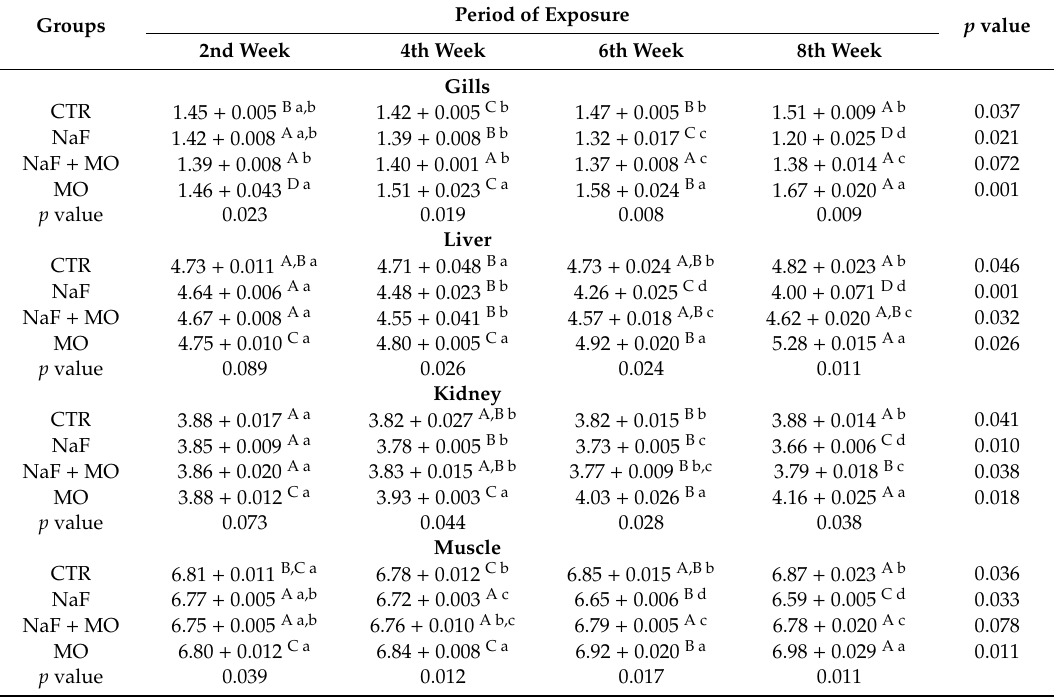
Table 9. E ff ect of sodium fluoride (NaF) and / or M. Oleifera (MO) on total antioxidant capacity (TAC) (U / g tissue) in tissue homogenates of O. niloticus gills, liver, kidney, and muscle. Groups